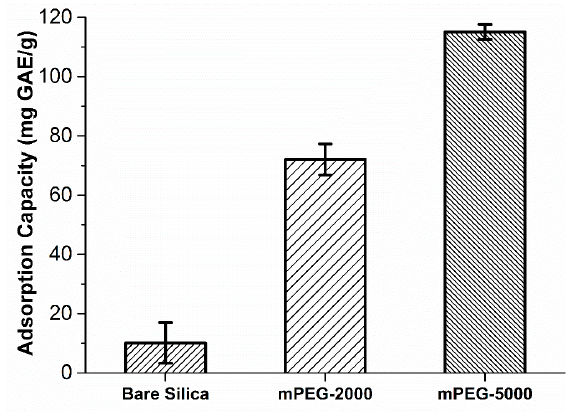
Figure 3. Adsorption capacities of bare, mPEG-2000-, and mPEG-5000-grafted silica particles for total polyphenols as determined by Folin–Ciocalteu method. Adsorption experiments were performed with 25 mg of adsorbents. A statistically significant di ff erence between all the capacity values was observed ( p < 0.05). Error bars indicate a standard deviation observed for duplicates. GAE: Gallic acid